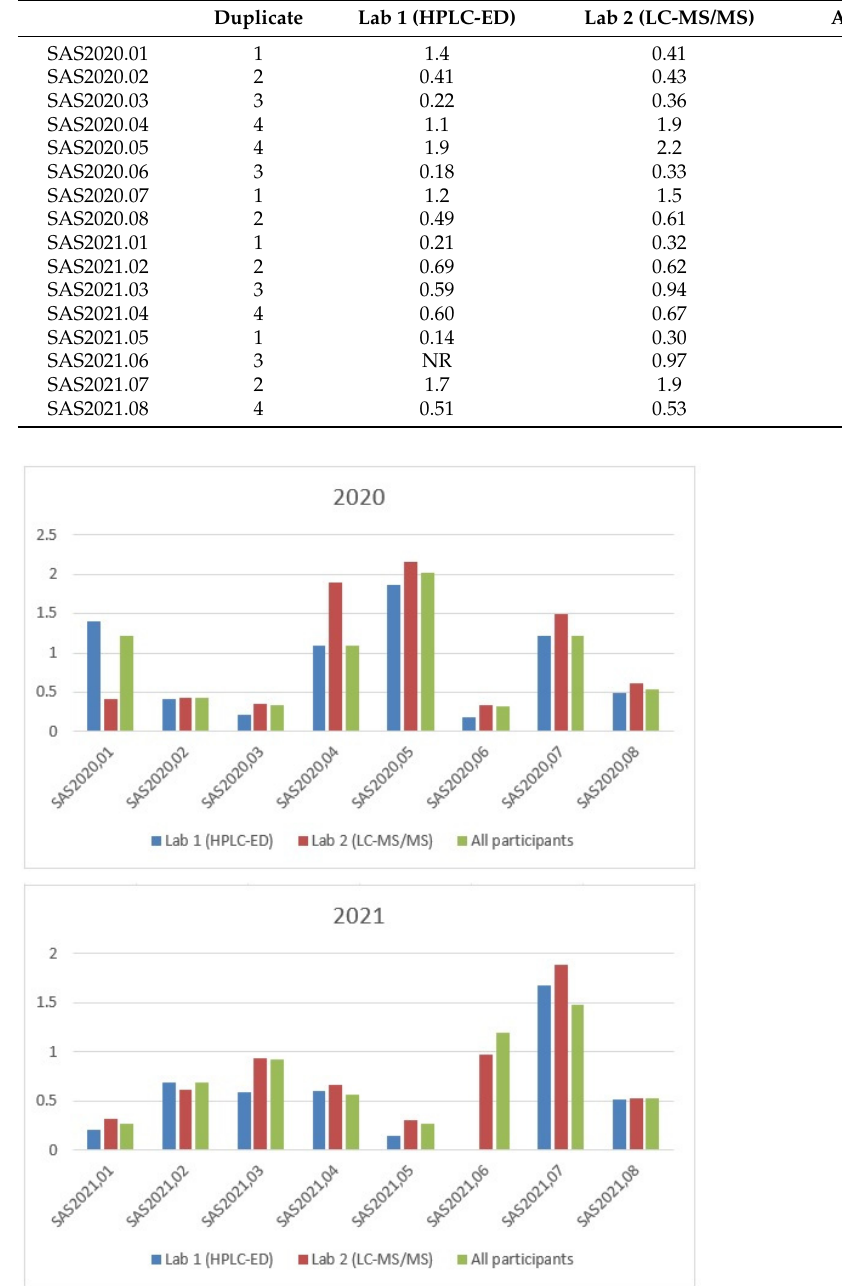
Figure 3. Visual comparison of the results of the EQC scheme for the plasma CoQ determination obtained with the HPLC-ED (Lab 1) and LC-MS/MS (Lab 2) methods, and from all participants during the 2020–2021 period. Mean values are stated for (Lab 1) and (Lab 2), while median values are reported for all participants. All data are expressed in µmol/L.